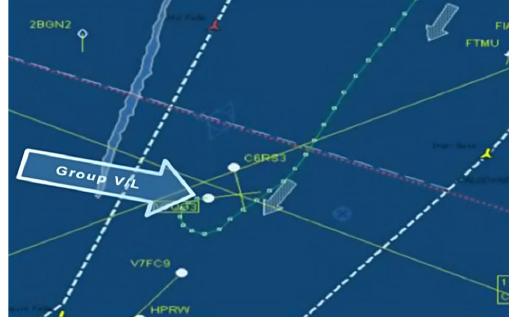
Figure 2. Observed vessel after turning to the opposite